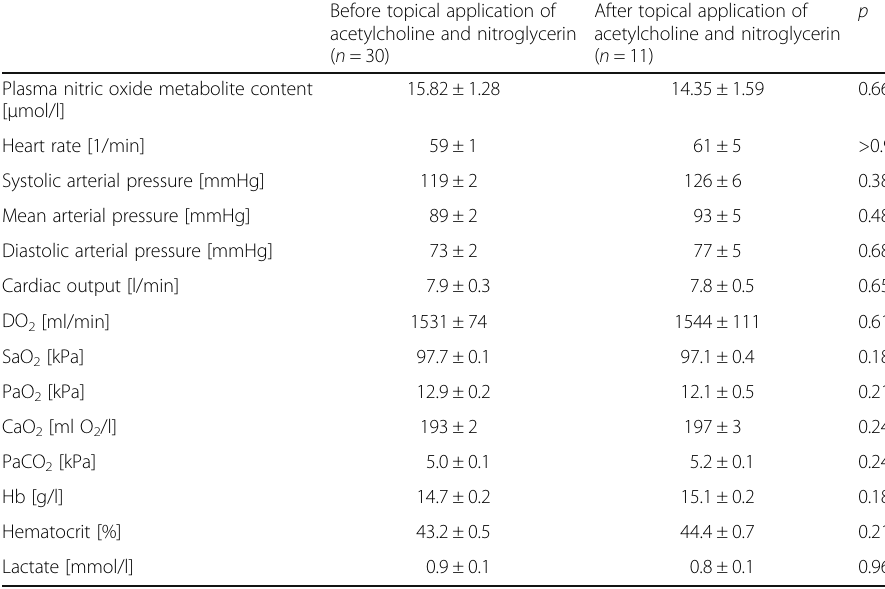
Table 1 Hemodynamic status and plasma nitric oxide metabolite content before and after the sublingual topical application of acetylcholine and nitroglycerin Before topical application of acetylcholine and nitroglycerin